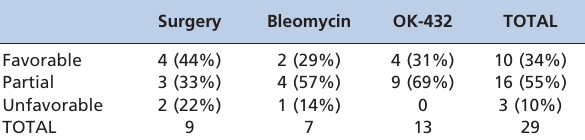
Table 3 - Use of surgery or injection as the initial procedure in each patient.